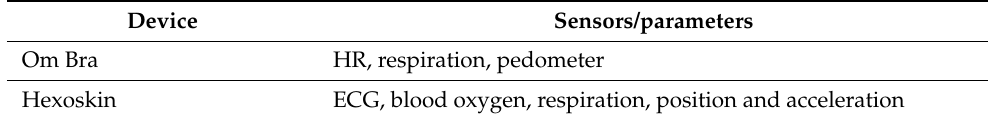
Table 7. Examples of wearable consumer grade clothing cardiac monitors.